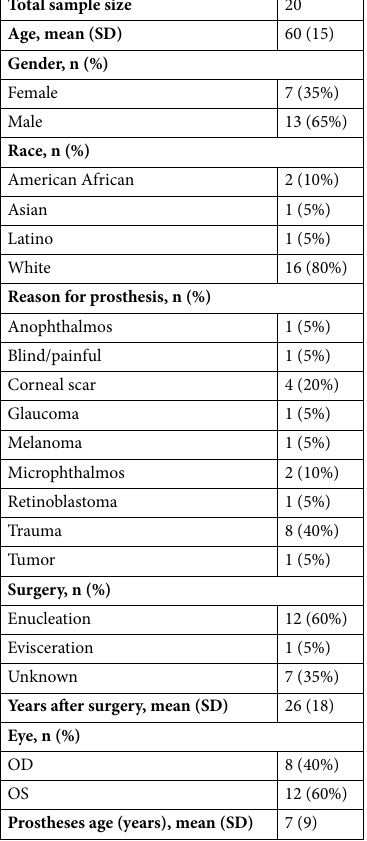
Table 2. Patient characteristics.